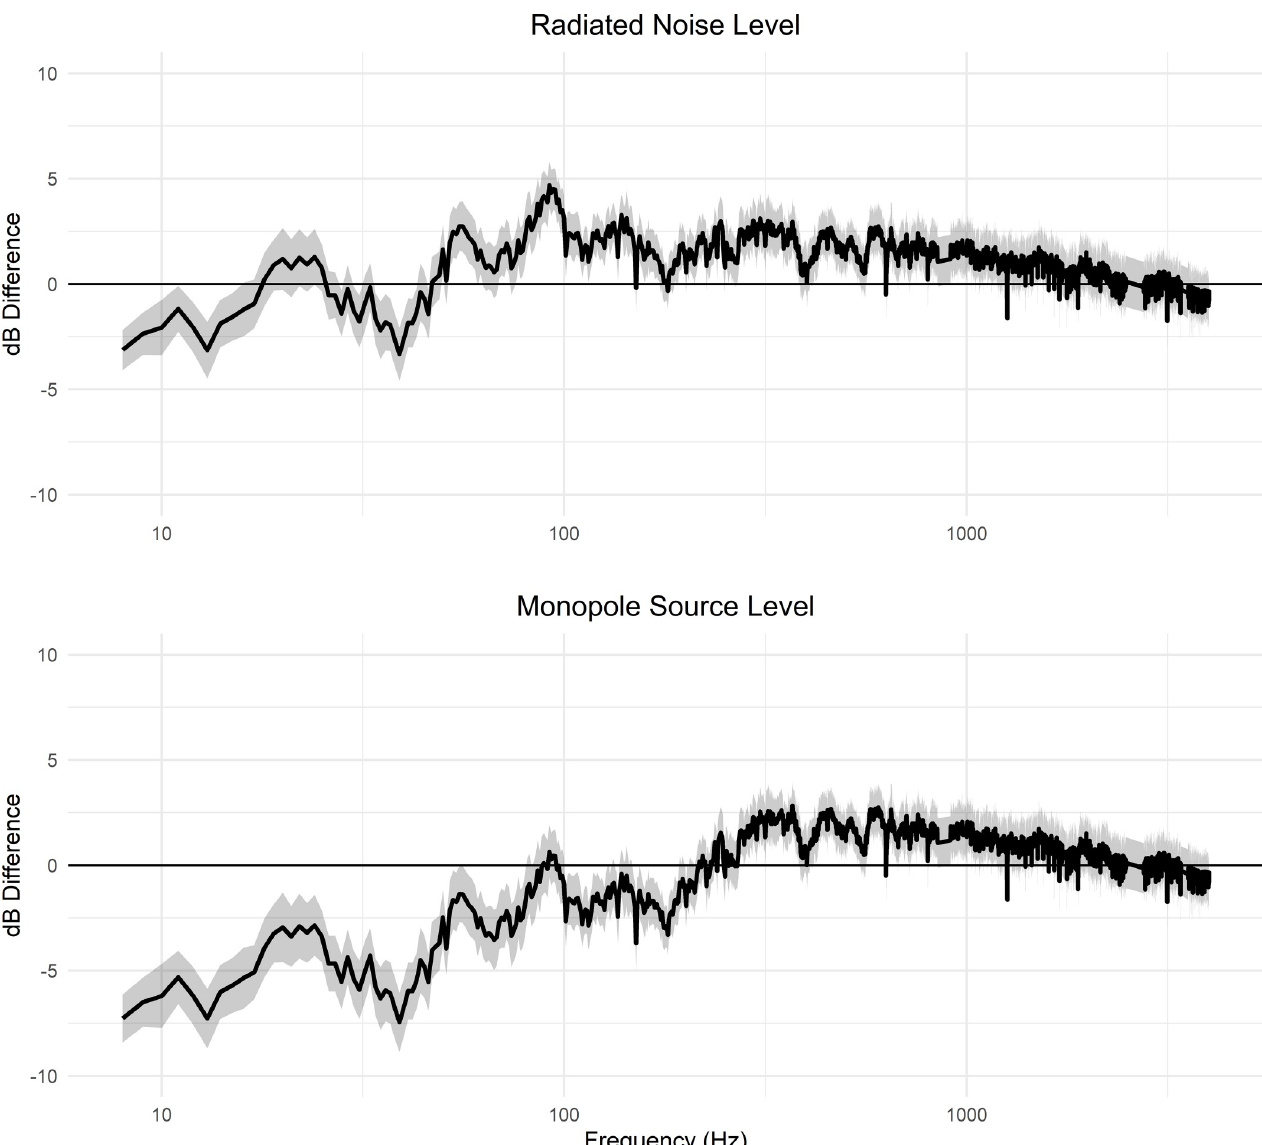
Fig 8. Difference in estimated marginal means for noise levels pre- and post-retrofitting. Difference +/- standard error of estimated marginal means pre- and post-retrofitting for radiated noise levels and monopole source levels.